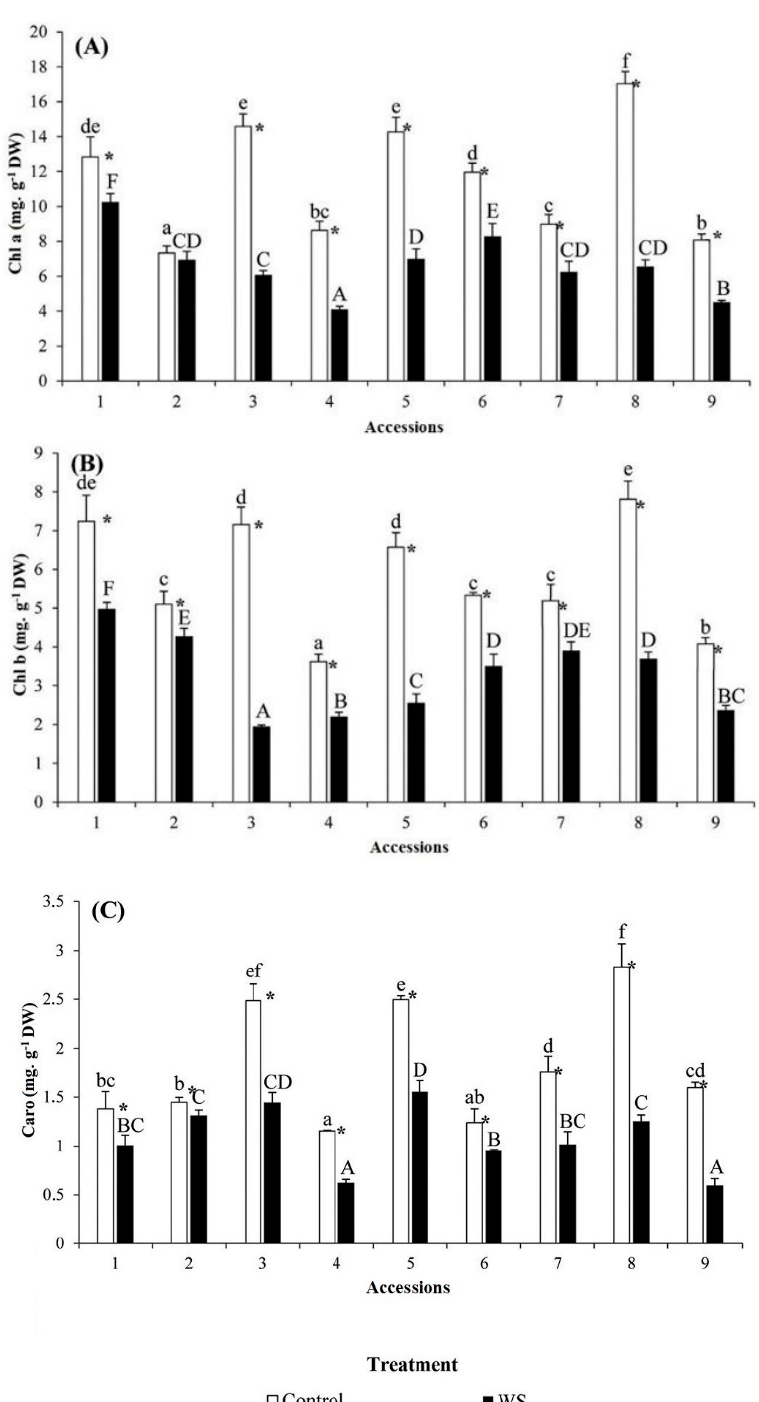
Figure 2. Variation in photosynthetic pigments content in the nine accessions of “Ardhaoui” barley landraces after three weeks of water stress (WS) treatment: ( A ) chlorophyll a (Chl a); ( B ) chlorophyll b (Chl b); and ( C ) total carotenoids (Caro). Error bars indicate SE ( n = 5). For each accession, asterisks (*) indicate significant differences between control and WS treatments and different letters indicate significant differences among accessions undergoing the same treatment, according to the Tukey test ( α = 0.05).